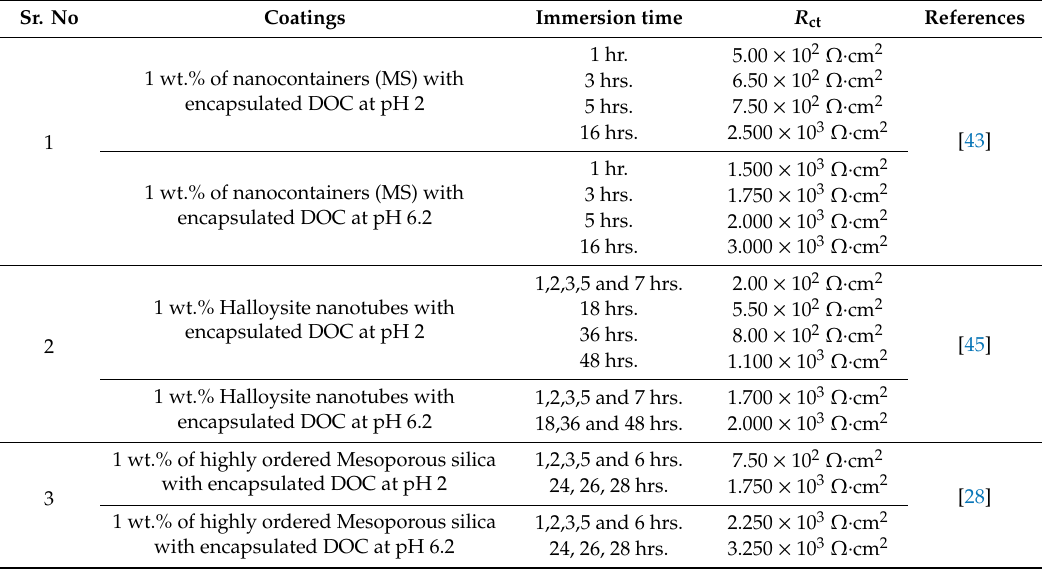
Table 2. Electrochemical impedance parameters from measured impedance data for coating of 5 wt.% TNTs loaded with DOC at pH 2 and